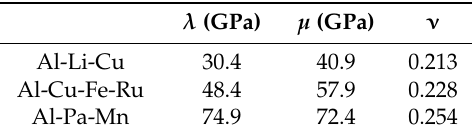
Table 1. Mechanical properties of icosahedral quasicrystals